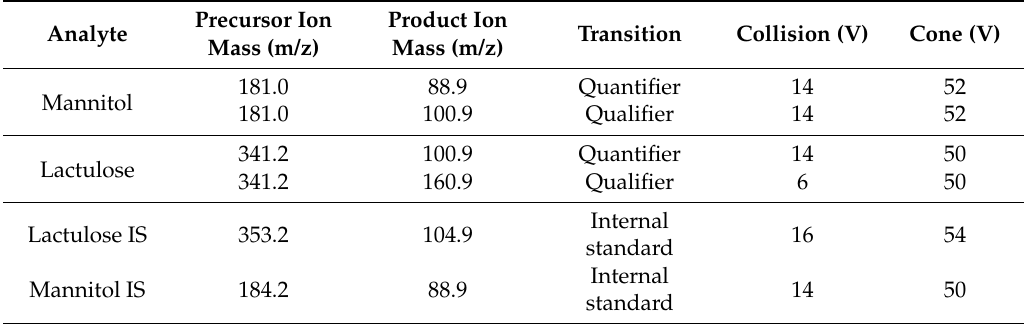
Table 2. Mass spectrometry